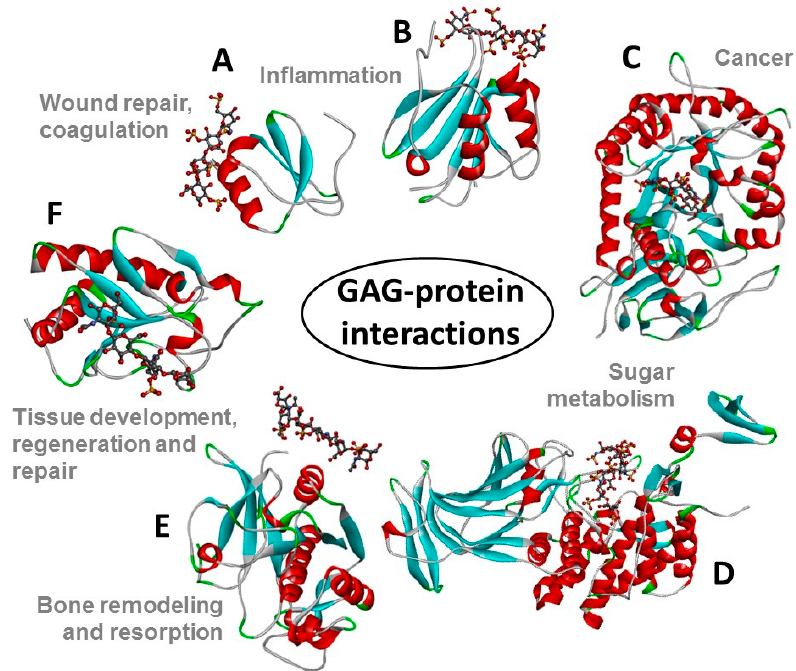
Figure 2. Structural representations from the crystal structures of some illustrative GAG-protein complexes in PDB: ( A ) macrophage inflammatory protein 1 α (CCL3) monomer + heparin tetrasaccharide (from 5D65) [13], ( B ) Platelet factor 4 (CXCL4) dimer + fondaparinux (antithrombin-high affinity heparin pentasaccharide) (from 4R9W) [14], ( C ) human heparanase complex + heparin tetrasaccharide (from 5E9C) [15], ( D ) D -glucuronyl C5-epimerase + heparin hexasaccharide (from 4PXQ) [16], ( E ) Cathepsin K monomer + dermatan sulfate hexasaccharide (from 4N79) [17], and ( F ) Sonic Hedgehog monomer + CS-A tetrasaccharide (from 4C4M) [18]. The atoms of the GAG ligands represented in the ball-stick view are carbon (grey), nitrogen (blue), hydrogen (light grey); oxygen (red) and sulfur (yellow). In the proteins, the α -helices, β -sheets, loops and random coils are represented respectively in red, blue, green, and grey. The pathophysiological systems in which these complexes play a role are indicated by grey fonts in the panel. Reprint with permission from MDPI Pharmaceuticals ( Basel ), 2018 , 11 ( 1 ) [12].